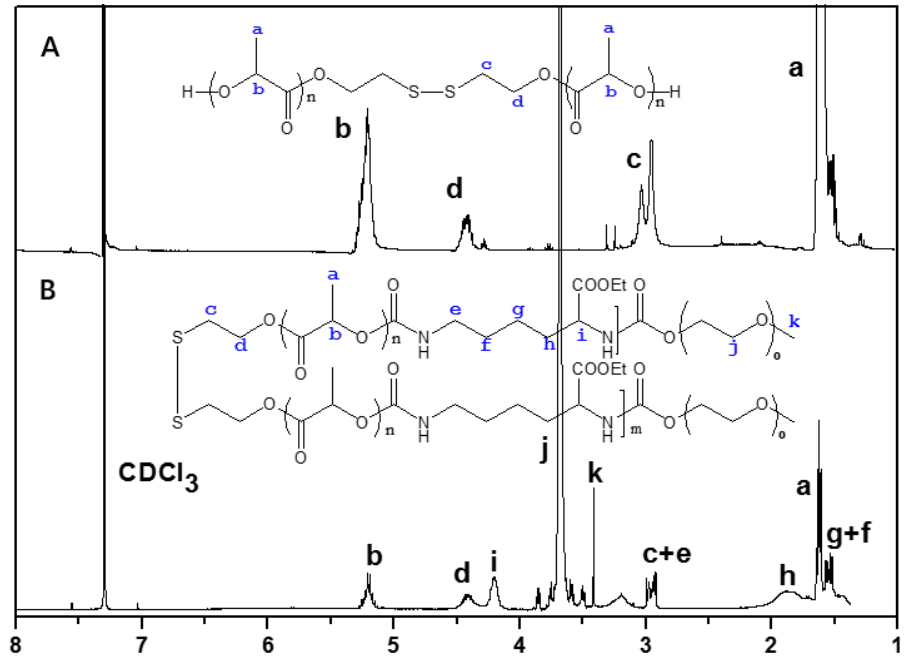
Table 1. Molecular characteristics of PEG-PU(SS)-PEG and PEG-PU-PEG.